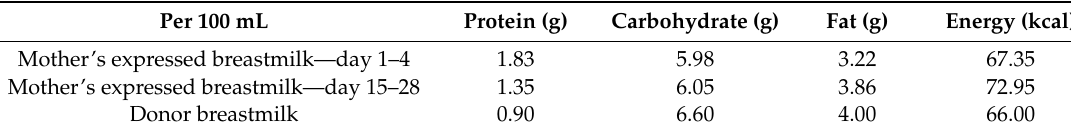
Table 1. Breastmilk composition used for